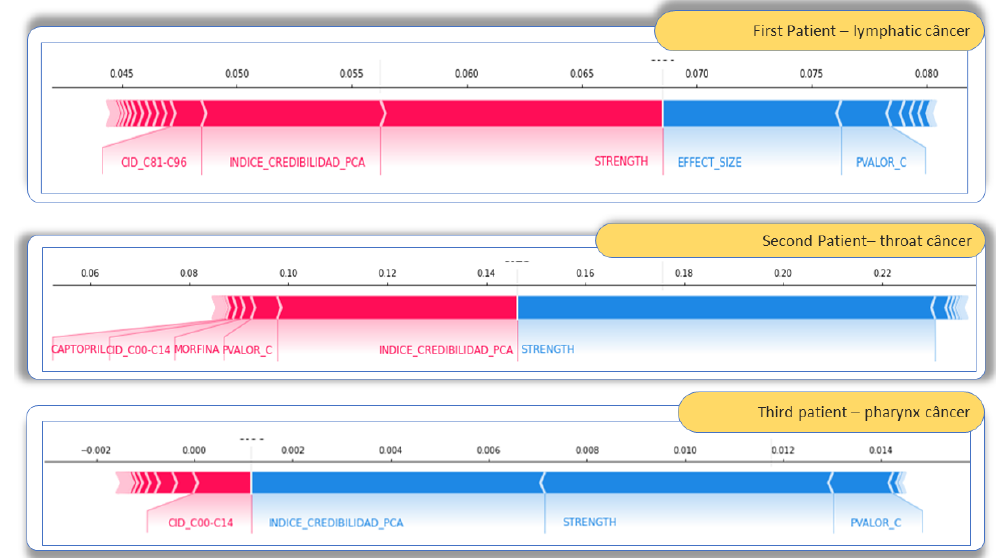
Figure 20. SHAP patient perspective